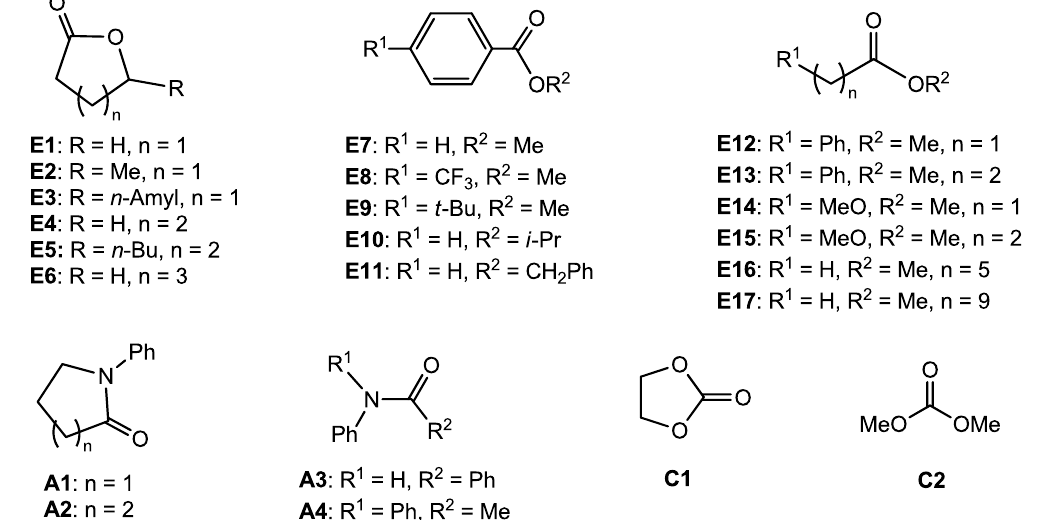
Figure 6. Substrates tested in this work.